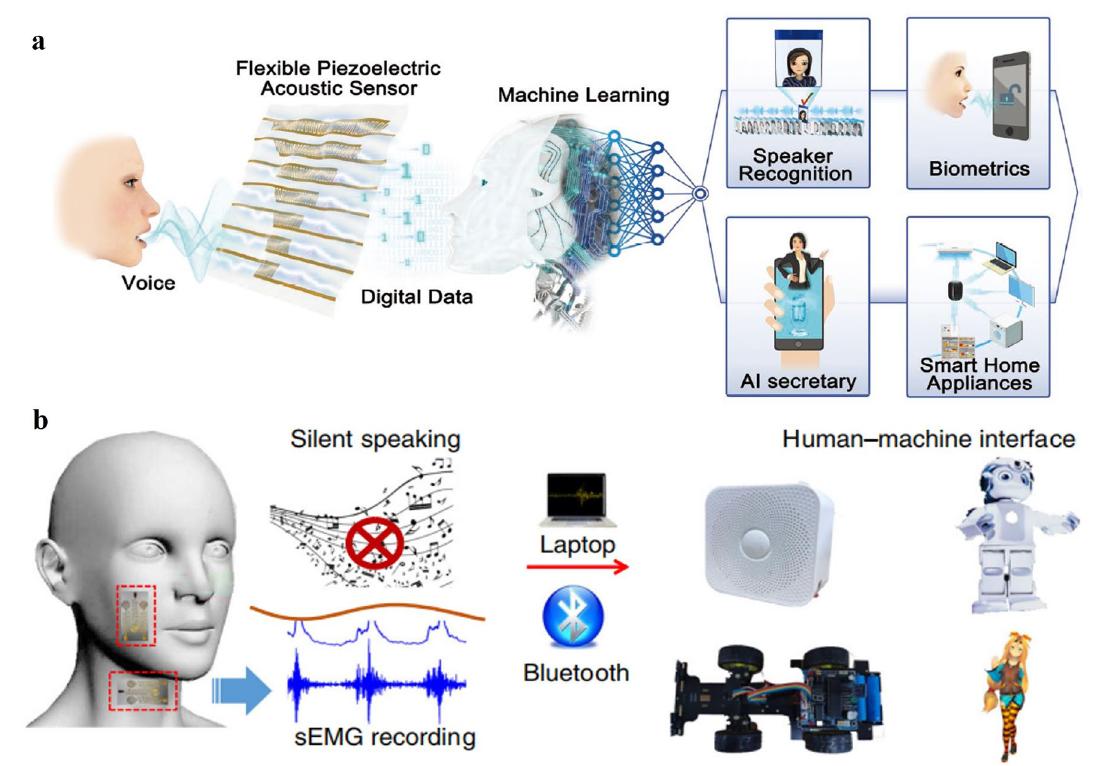
Fig. 10 a HMI applications of voice communication enabled by the flexible piezoelectric pressure sensor and ML techniques [27]. Copyright (2019) Wiley–VCH. b HMI applications of silent speaking enabled by the flexible sEMG sensors and ML techniques [191]. Copyright (2020) The